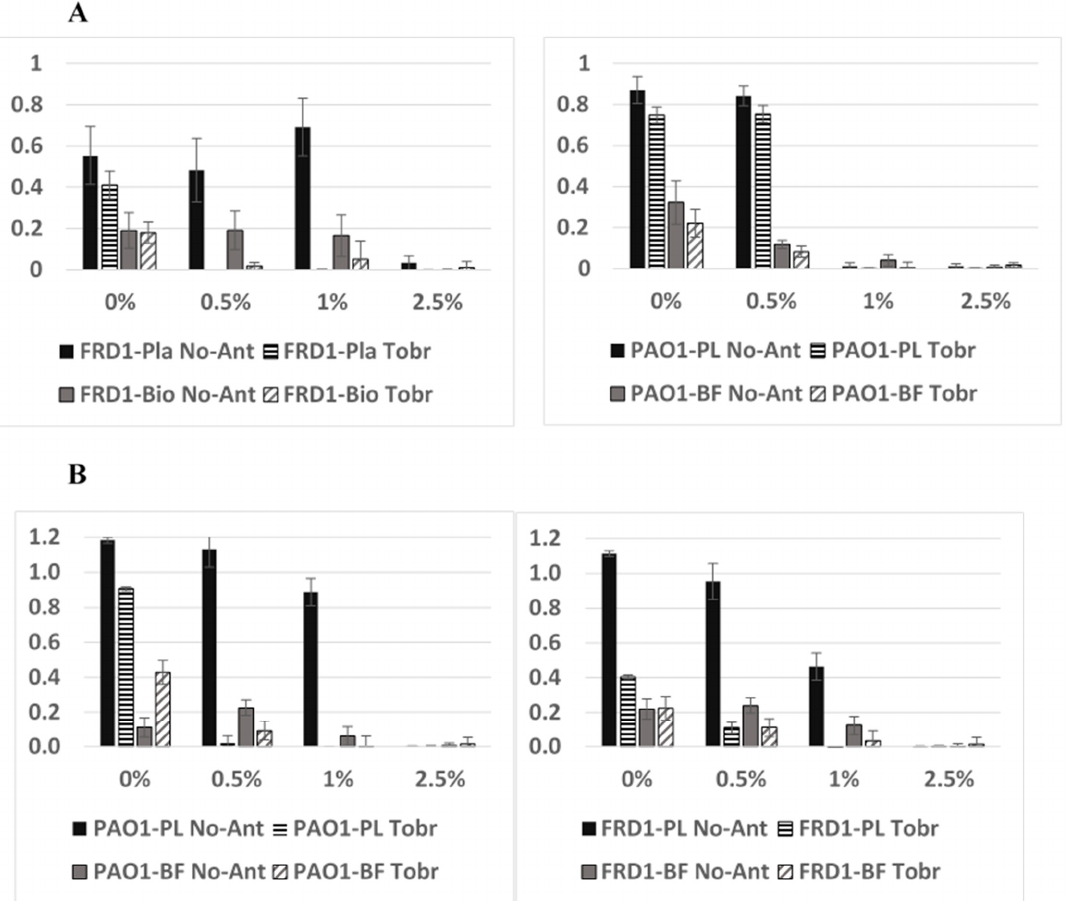
Figure 7. Combined effect of Ag(PiCO), red polymorph, ( A ) or Ag(BTCO) ( B ) with Tobramycin on biofilm (BF) and planktonic (PL) growth of P. aeruginosa PAO1 and FRD1. Tobramycin was added at sub-inhibitory concentration of 0.25 µg/ml. Planktonic growth was measured by absorbance at 600 nm and biofilm growth was quantified by Crystal Violet Assay.